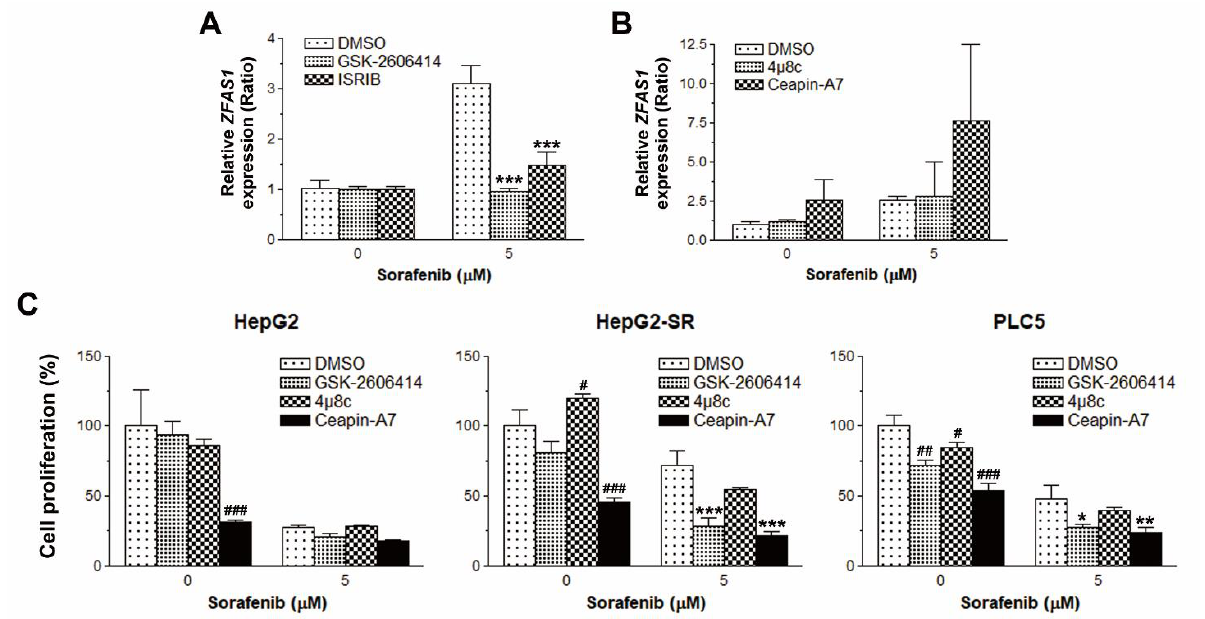
Figure 7. The effect of UPR inhibitors on sorafenib-induced ZFAS1 . ( A , B ) PLC5 cells were pretreated with 10 μM GSK-2606414, 0.2 μM ISRIB, 10 μM 4μ8C, or 10 μM Ceapin-A7 for 0.5 h, and then exposed to 5 μM sorafenib for 18 h. ZFAS1 expression was analyzed by real-time qPCR. *** p < 0.001 indicated the statistically significant difference between sorafenib-treated and UPR inhibitor/sorafenib-treated cells. ( C ) HepG2, HepG2-SR, and PLC5 cells were treated with 5 μM sorafenib for 48 h in the absence or presence of 10 μM GSK-2606414, 10 μM 4μ8C, or 5 μM Ceapin-A7. The cell proliferation was examined by BrdU incorporation assay. # p < 0.05, ## p < 0.01, and ### p < 0.001 indicated the statistically significant difference between untreated and UPR inhibitor-treated cells. * p < 0.05, ** p < 0.01, and *** p < 0.001 indicated the statistically significant difference between sorafenib-treated and UPR inhibitor/sorafenib-treated cells.